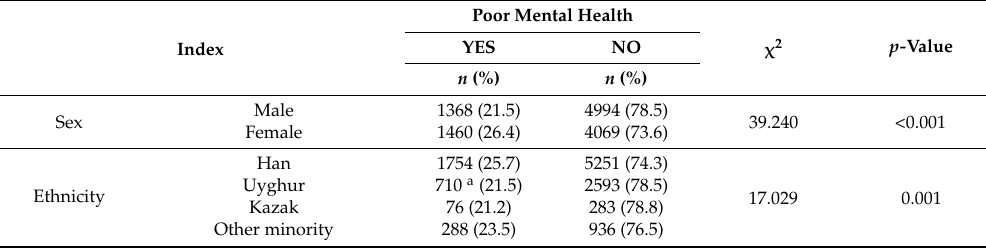
Table 2. The prevalence of poor mental health among sub-groups ( n =